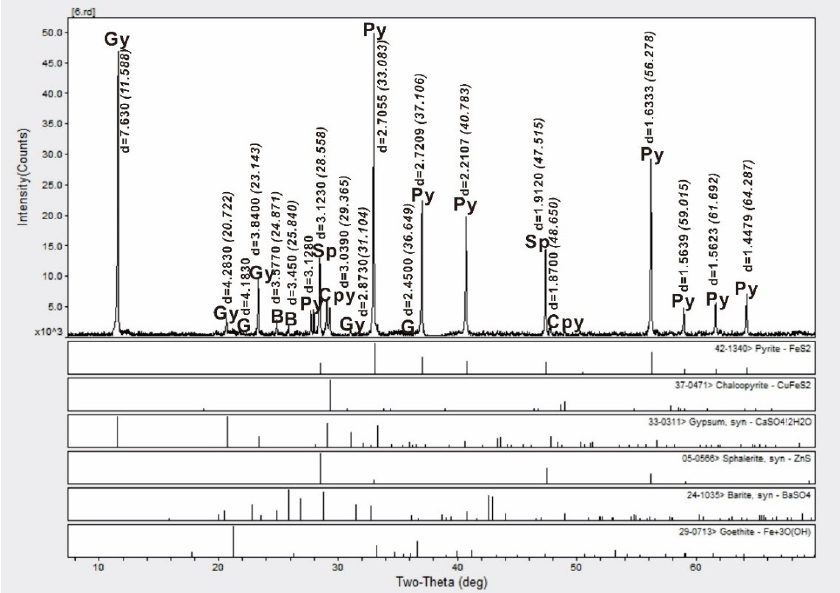
Figure A3. Bulk XRD patterns of representative samples of Wocan-1 (station 28I-TVG08); the 2θ values are enclosed in the bracket, whereas the first values are the d values. Characteristic peak values were compared with References [35,36]. Abbreviations G: Goethite; B: Barite; Sp: sphalerite; Cpy: chalcopyrite; Py: pyrite, Gy: Gypsum.